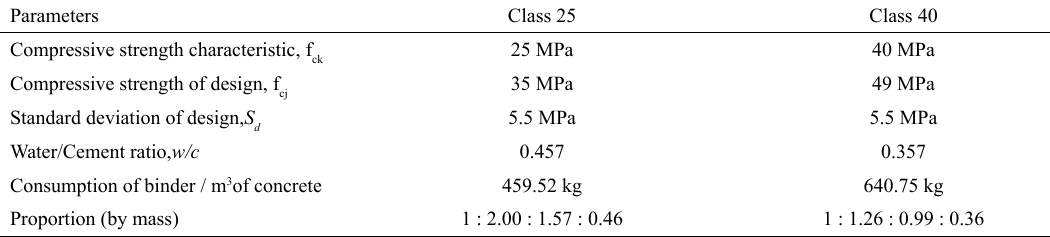
Table 1. Concrete design parameters of classes 25 and 40